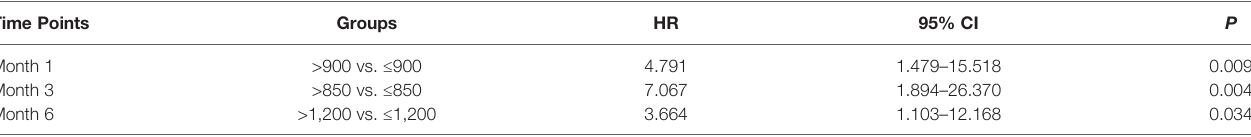
TABLE 3 | Risk for de novo DSA after kidney transplantation (KTx) in high-level sBAFF group vs. low-level sBAFF group at different time points. Time